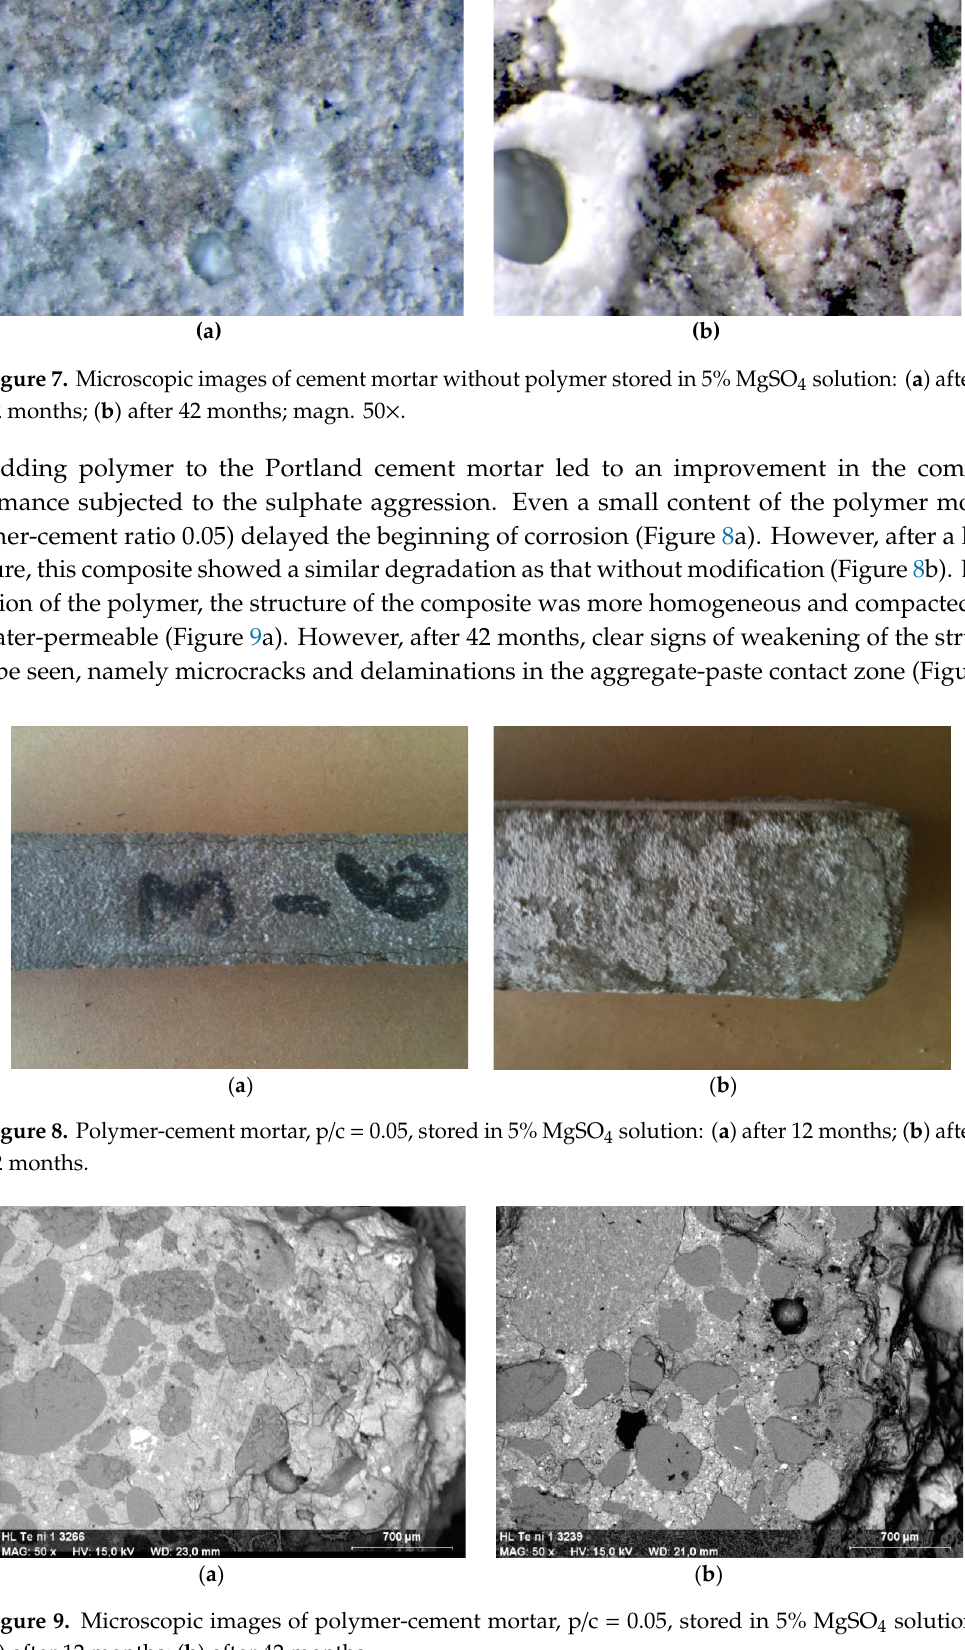
Figure 6. Cement mortar without polymer stored in 5% MgSO 4 solution: ( a ) after 12 months; ( b ) after 42 months.